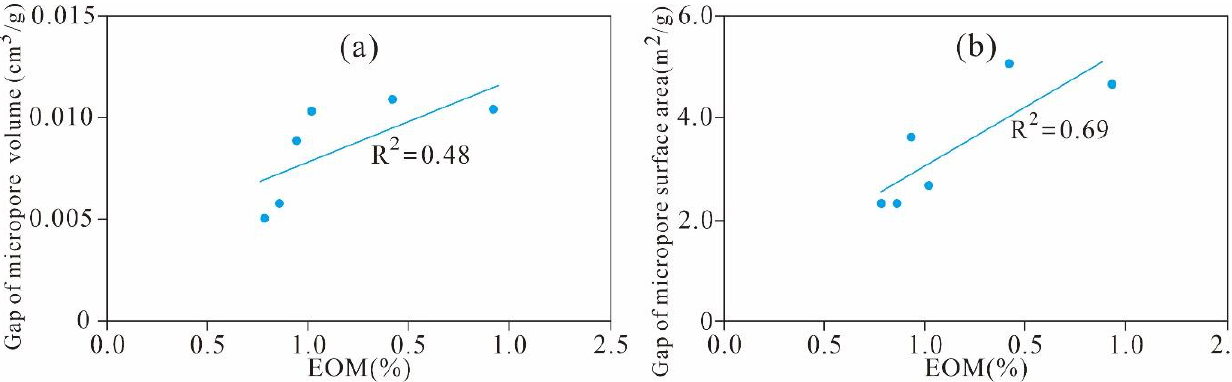
Figure 22. Relationships between the EOM and gap value of the ( a ) micropore volume and ( b ) surface area.